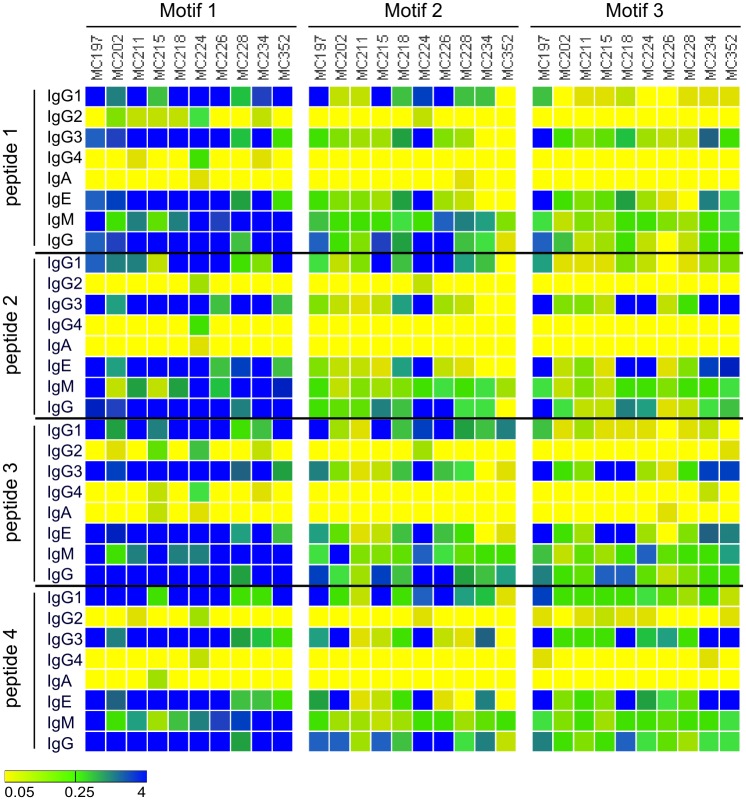
Isotype profiling of the immune response against the peptides containing motifs.Immunoreactivity against the 12 selected peptides was determined in 10 samples using a set of detection antibodies that specifically bind IgG1, IgG2, IgG3, IgG4, IgA, IgE, IgM and IgG. The 4 peptides that were analyzed for motif 1 were OVOC5897;457 (peptide 1), OVOC4989;3619 (peptide 2), OVOC5528;169 (peptide 3) and OVOC9141;595 (peptide 4). The 4 peptides that were analyzed for motif 2 were OVOC7266;283 (peptide 1), OVOC1743;211 (peptide 2), OVOC1920;985 (peptide 3) and OVOC3954;793 (peptide 4). The 4 peptides that were analyzed for motif 3 were OVOC2898;313 (peptide 1), OVOC437;181 (peptide 2), OVOC9199;139 (peptide 3) and OVOC11846;559 (peptide 4). Color scale indicates Abs450nm with yellow corresponding to background absorbance (i.e. 0.05) and blue maximal absorbance (i.e. 4).